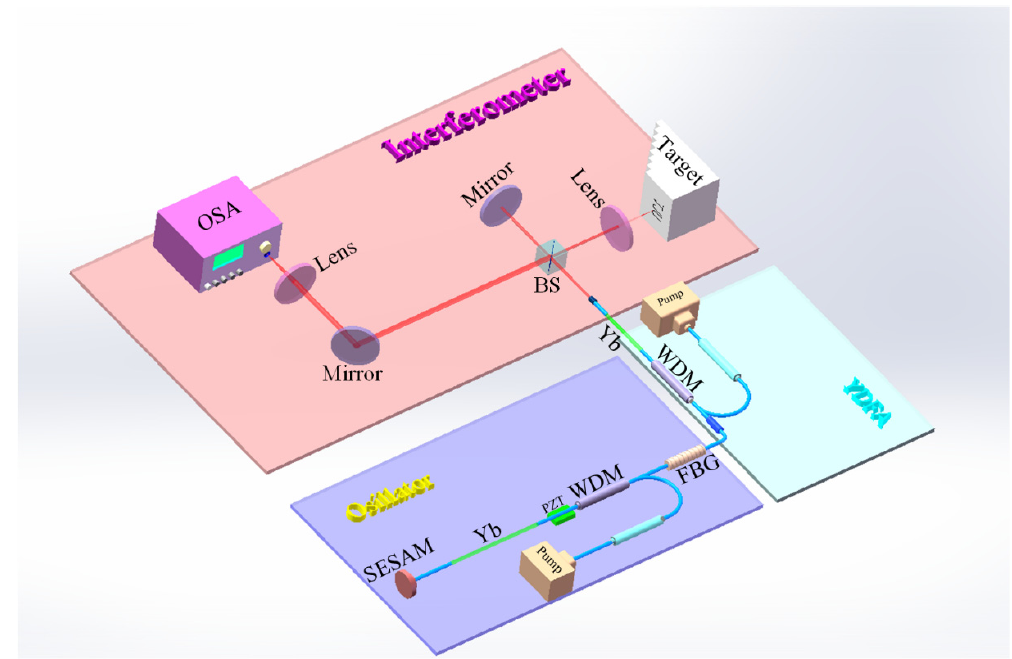
Figure 1. Experimental schematic of the three-dimensional imager, which is composed of three parts: oscillator (purple background), YDFA (light blue background), and interferometer (light red background). SESAM: semiconductor saturable absorber; PZT: piezoelectric transducer; WDM: wavelength division multiplexing; FBG: fiber Bragg grating; YDFA: Yb–doped fiber amplifier; BS: beam splitter; OSA: optical spectrum analyzer.